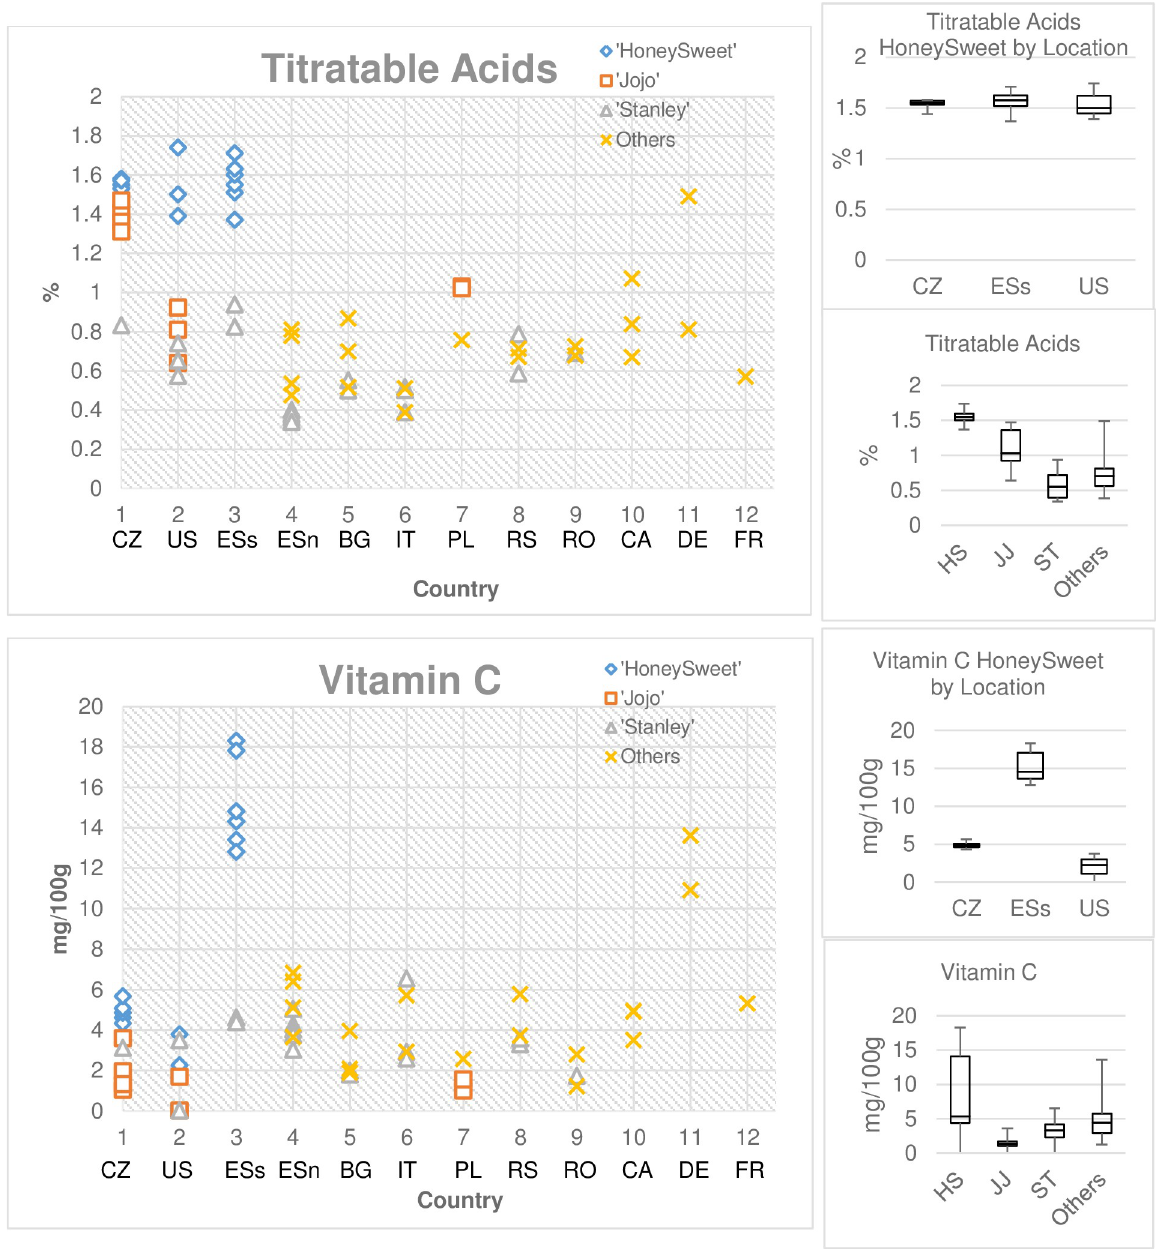
Fig 3. Effects by location. Titratable acid is again consistently high in ‘HoneySweet’ regardless of the location. In contrast, the vitamin C level is affected by location. Where it is consistently high in the southern Spain location for ‘HoneySweet’ as well as two cultivars in Germany. The box plot graphes further show the effect using averages and high and low points. CZ-Czech Republic, US-United States, ESs-southern Spain, ESn- northern Spain, BG-Bulgaria, IT-Italy, PL-Poland, RS-Serbia, RO-Romania, CA-Canada, DE-Germany, FR-France, HS-‘HoneySweet’, JJ-‘Jojo’,